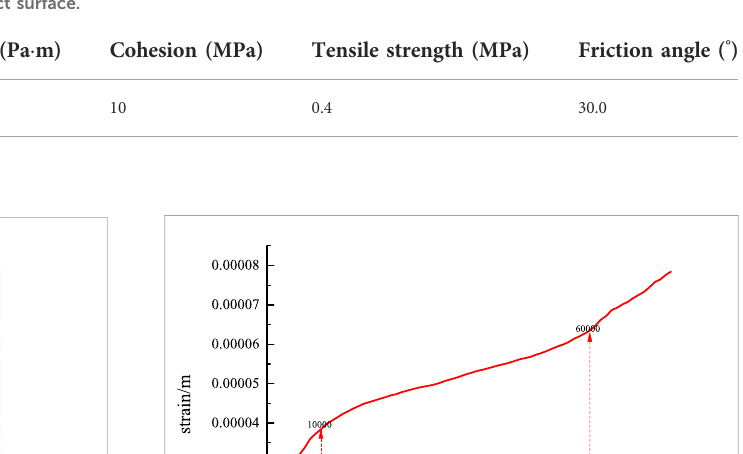
TABLE 3 Mechanical parameters of the rock mass contact surface.